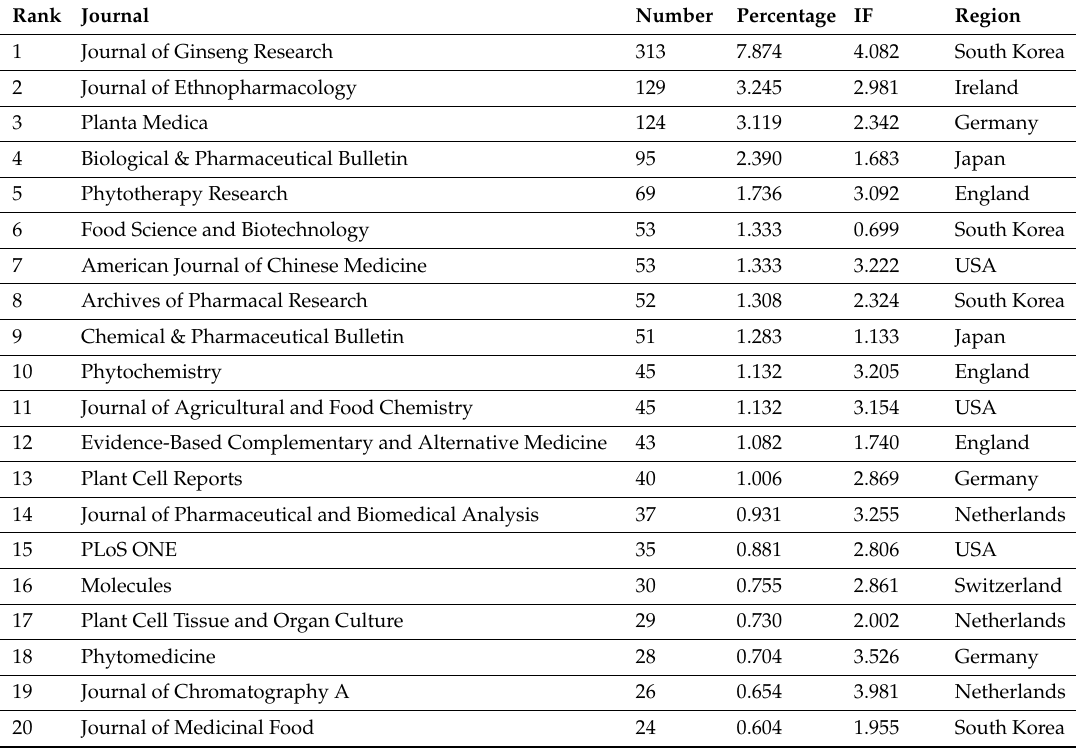
Table 3. The information about top 20 highest publishing journals.